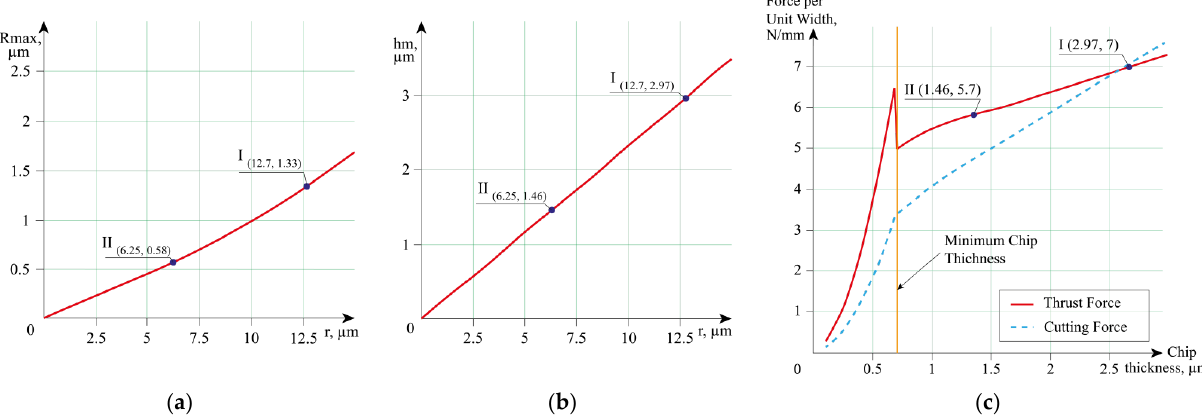
Figure 16. ( a ) Residual height of residual microroughness ( R max ); ( b ) minimum undeformed chip thickness h m ; ( c ) forces in the ploughing-dominated region: point I — micro end mill coated after etching by fast atoms, point II — micro end mill coated after grinding.